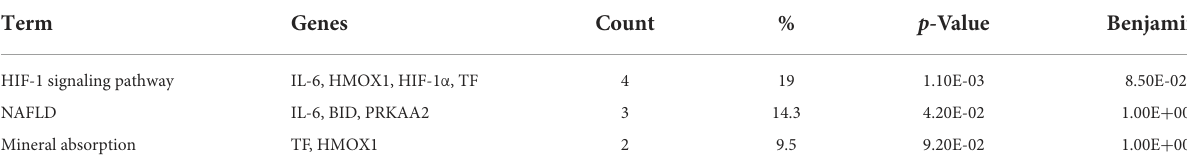
TABLE 3 Three biological pathways were significantly activated by using DAVID. Term